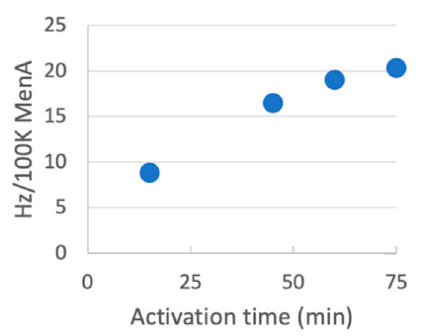
Figure 9. Time course of activation of MenA polysaccharide at pH 8 at 0 °C. 5 mg/mL MenA was brought to pH 8 with DMAP at 0 °C and CDAP added to 2.5 mg/mL. The pH was maintained at 8 with 0.1 M NaOH. At the indicated times, 0.5 mL was removed and combined with 0.5 mL of 0.5 M ADH in 0.1 M HEPES, pH 8. After a 1 h reaction, each was desalted by a combination of dialysis and centrifugal filtration using an Amicon4 10 kDa cutoff device. The hydrazide and MenA concentrations were assayed to determine the hydrazide:MenA ratio.